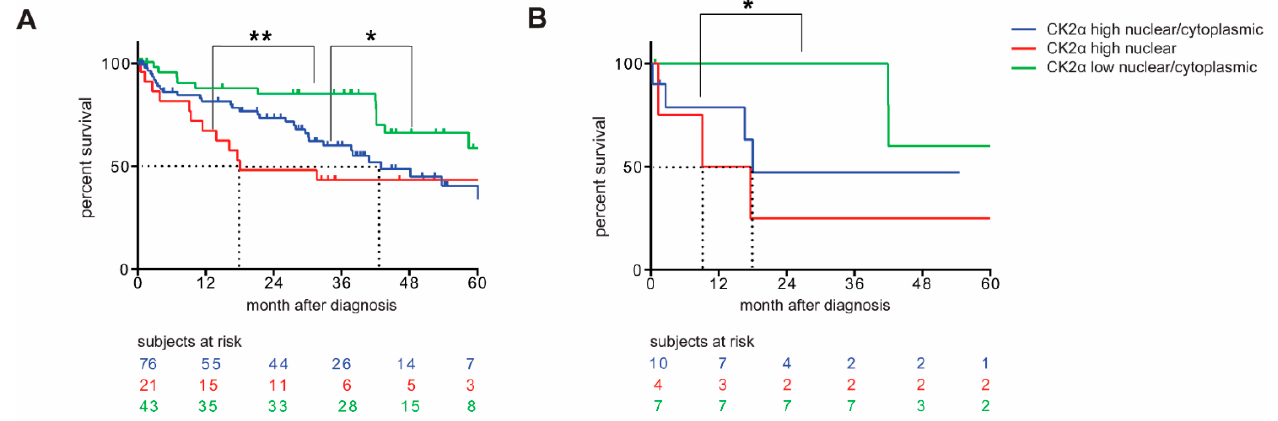
Figure 3. Level and localization of CK2 α expression correlate with different overall survival in patients with CRC. CRC cases were grouped into high nuclear/cytoplasmic (blue line), high nuclear (red line) or low nuclear/cytoplasmic (green line) CK2 α‐ expressing tumors and survival outcomes were analyzed by Cox proportional hazards model. ( A ) Comparison of survival outcomes within the whole CRC cohort; ( B ) Comparison of survival outcomes in a selected panel of patients, which were used for further exploratory analysis. Tumors of patients with the lowest survival outcome show high nuclear CK2 α expression in the whole cohort, as well as in the selected panel of CRCs. Results with a p ‐ value < 0.05 (*) or < 0.005 (**) are considered statistically significant. Table 2. Overall survival in the cohort analyzed by multivariable Cox